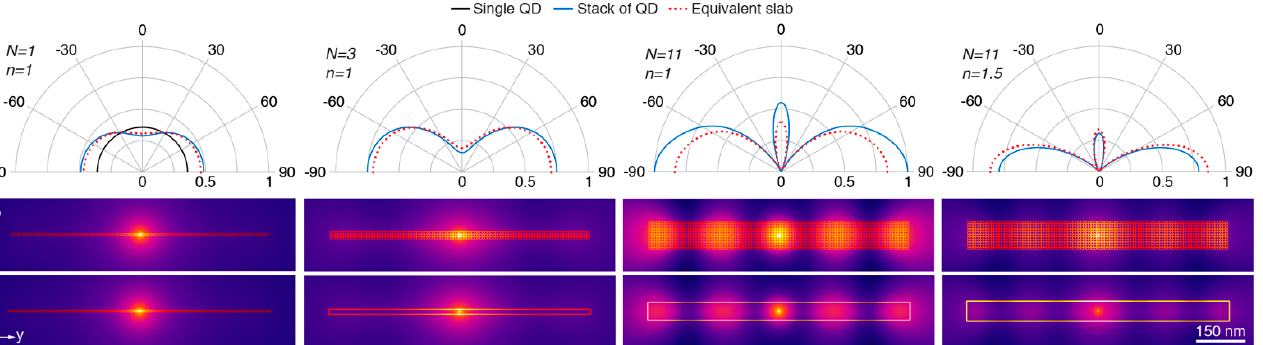
Figure 5. Emission properties of layered SNPs . ( a ) Calculated far-field emission patterns for a 1D dipole along the z-axis placed in a layer of cylindrical SNPs (blue solid lines) in a stack with different numbers of layers N, with surrounding medium n (outer left N = 1, center left N = 3, center right N = 11 with n = 1; outer right N = 11 with n = 1.5) and in an equivalent slab (red dotted lines). ( b ) Corresponding simulated near-field distributions of the dipole emission for the stack of SNPs (top row) and for the equivalent slab (bottom row).